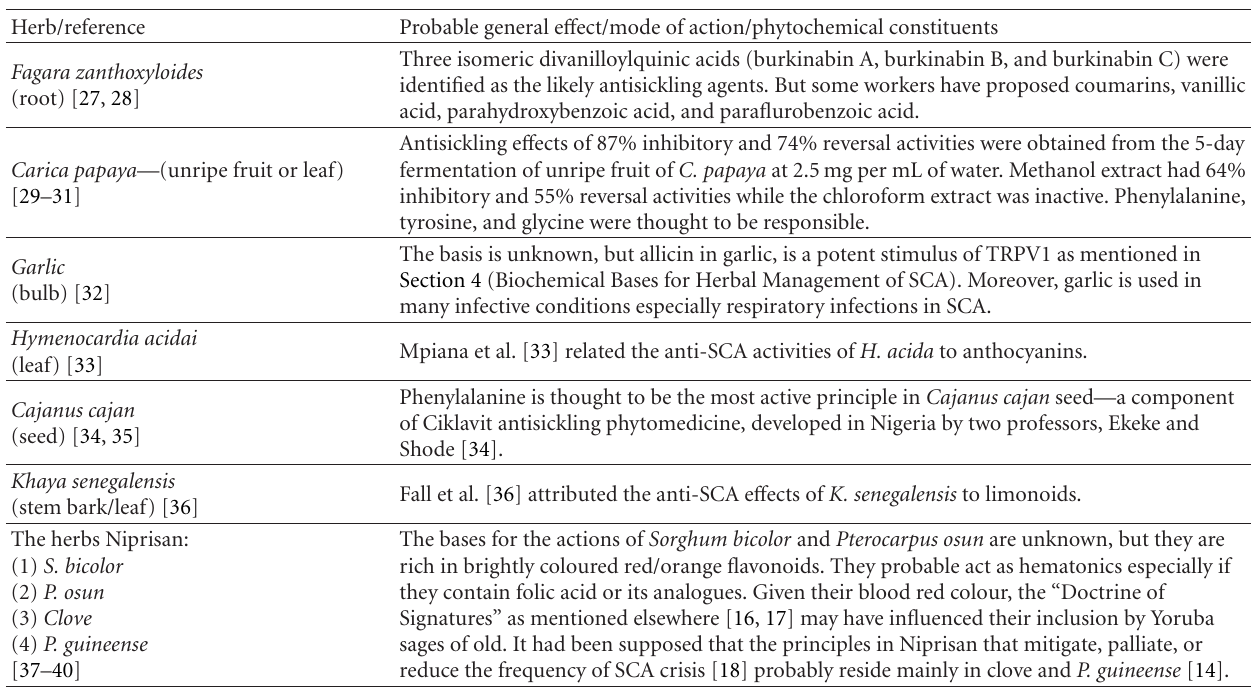
Table 2: Herbal materials used in managing SCA and its probable modes of